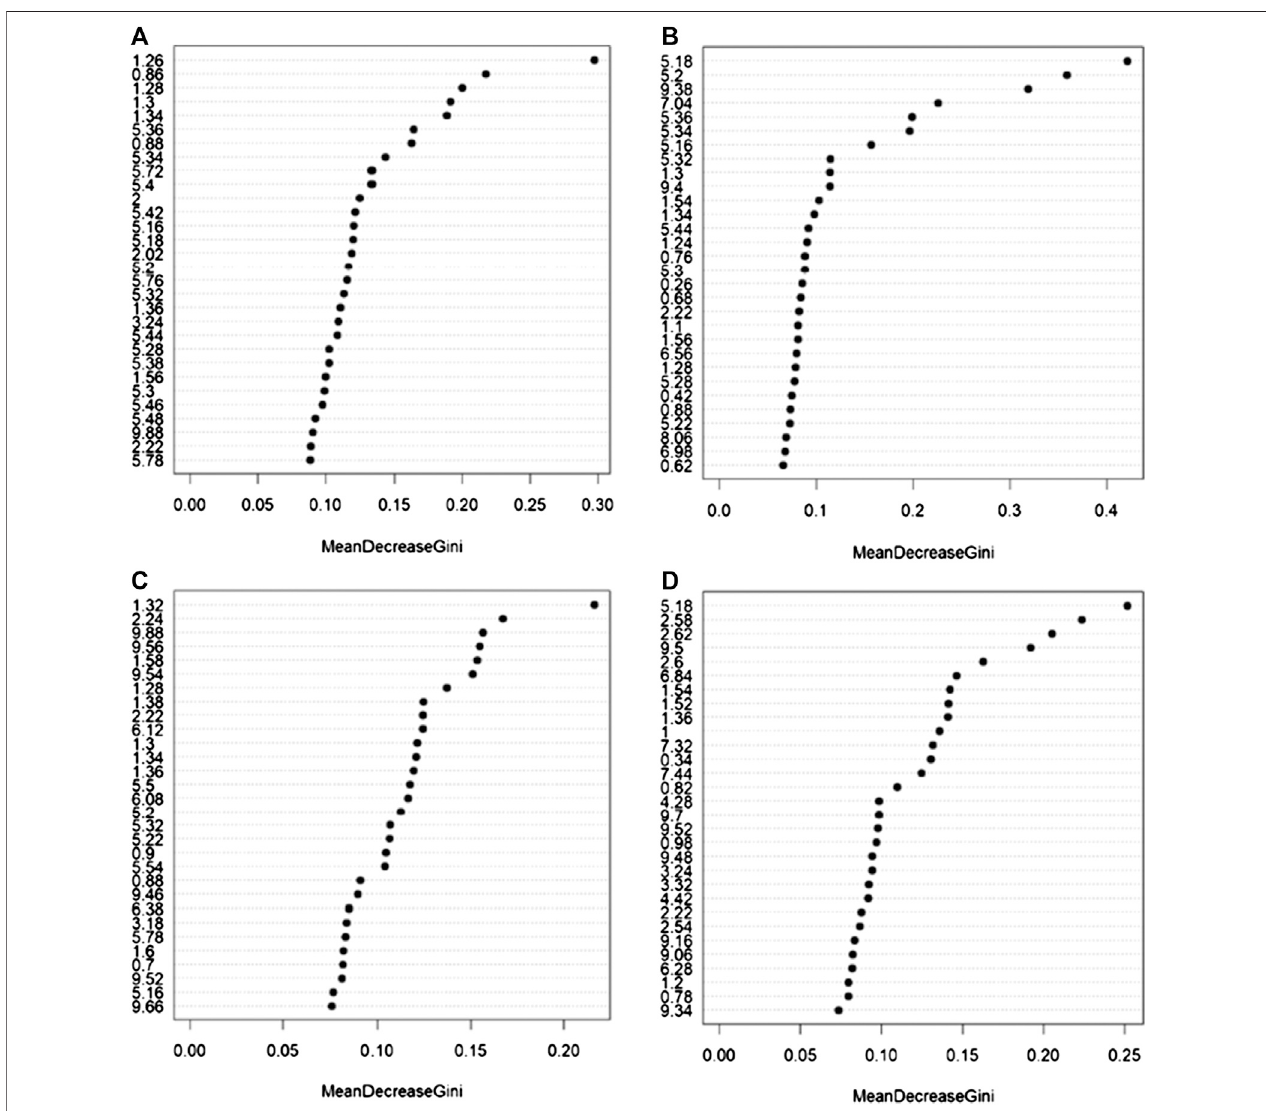
FIGURE5| Binsthat mainly contribute to thediscrimination between patients thatexperienced and not experienced adverseeffects tothe administration ofPDE5 inhibitors calculated on the NMR spectra acquired: (A) serum NOESY; (B) serum CPMG; (C) serum DIFFUSION; (D) urine NOESY. The importance is measured by the Gini